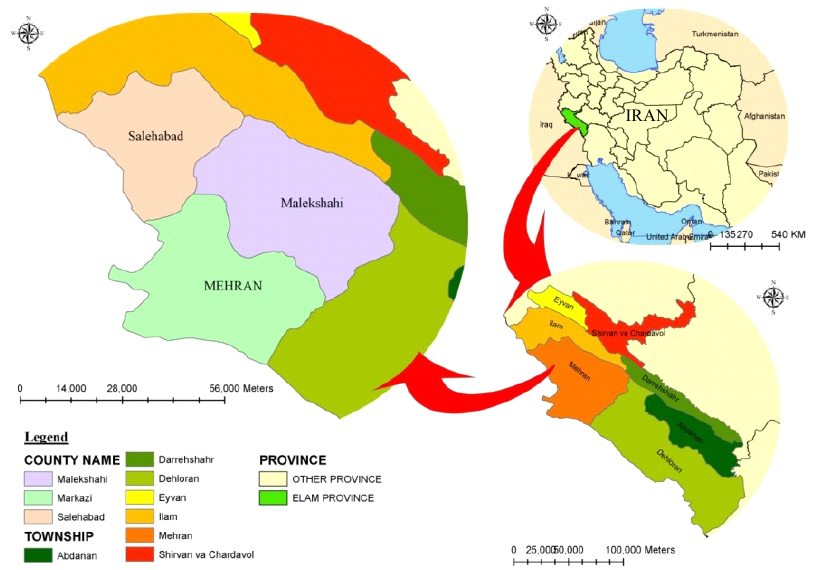
Fig. 1: Situation of the study